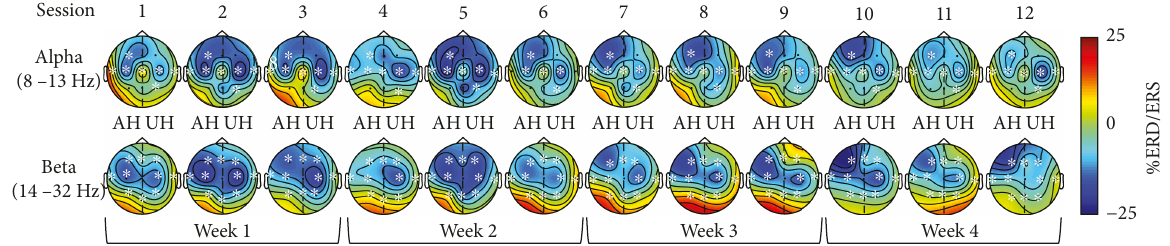
Figure 3: Grand average topographic maps of ERD/ERS during MI are observed across each session. Blue tones show ERD and red tones show ERS. All maps are plotted using the same scale. A ff ected (AH) and una ff ected hemispheres (UH) are shown. Channels with signi fi cant di ff erences across sessions are marked ( ∗ ).